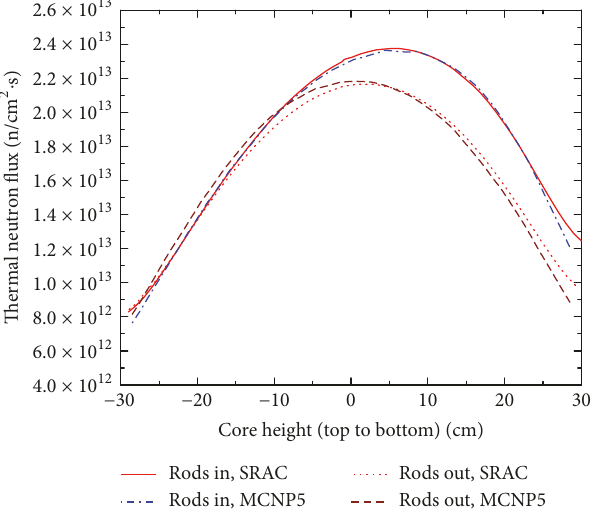
Figure 10: Thermal neutron flux distribution along the fuel bundles 7-10 and 9-6 at the critical core condition corresponding to the insertion of control rods ShR = 45.7 cm and AR = 40 cm.